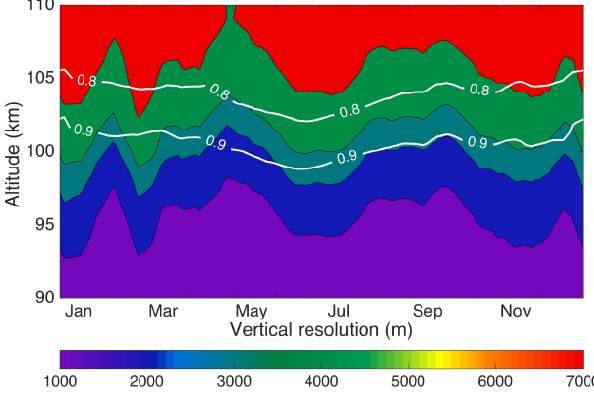
Figure 8. The OEM vertical resolution. The vertical resolution be- low 80km is 1056m; that is, it is equal to the retrieval grid spacing (not shown). The white lines are the height below which the tem- perature climatology is more than 90% (0.9) and 80% (0.8) due to the